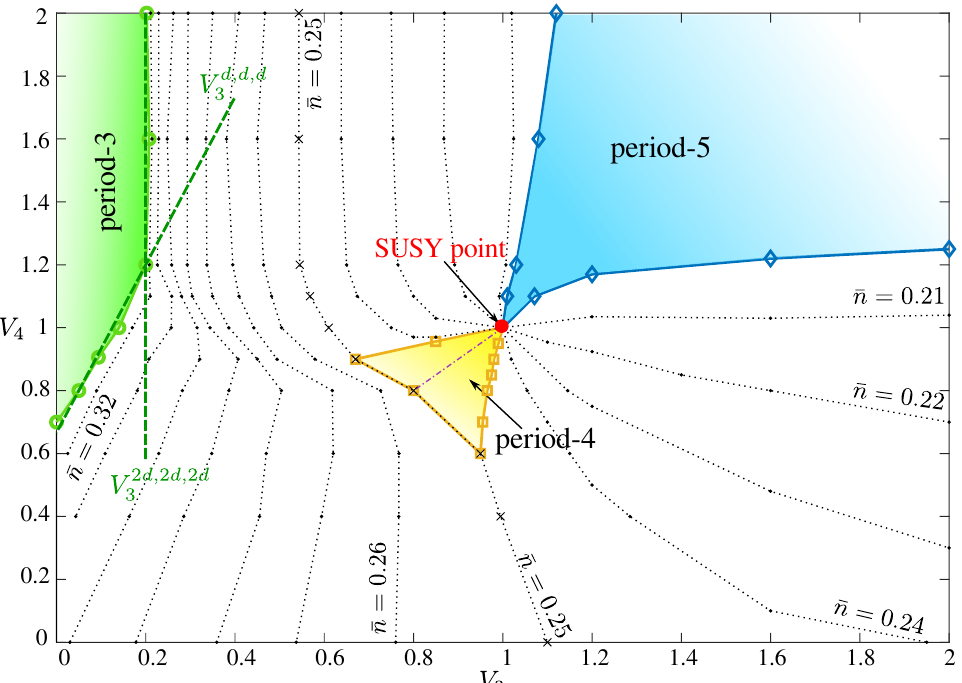
Figure 2: Phase diagram of constrained fermion model Eq. (4) on a zig-zag ladder as a function of third and fourth nearest neighbor interactions V point (red dot) is a multicritical point between period-4 (yellow) and period-5 (blue) gapped phases and the floating phase. At small V system is in the classical period-3 phase. Dotted lines are equal-density lines inside the floating phase. The dash-dotted line marks the location where the valence-bond solid type pattern ( 0.5,0.5,0,0 ) is the exact ground state. The dashed green lines indicate the estimated boundaries of period-3 phase delimited by the leading insta- bilities given by the three single and double defects V d , d , d